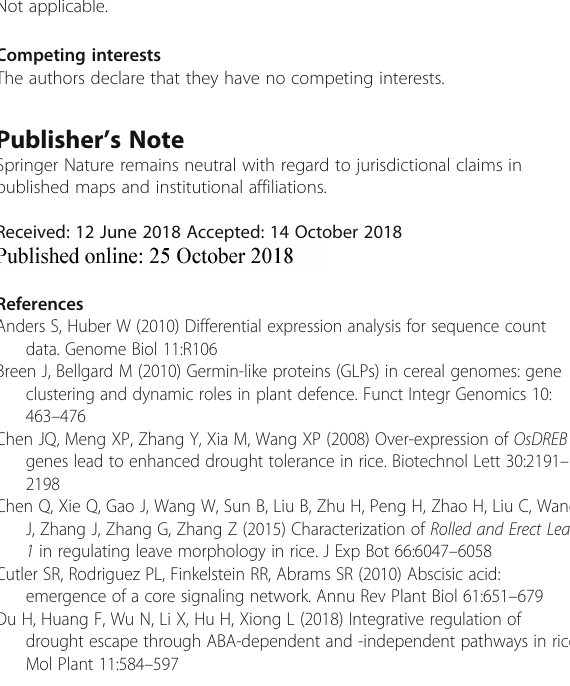
and its (Additional file 1: Table S12, Additional file 2: Table S1, Additional file 3: Figure S1, Additional file 4: Figure S2, Additional file 5: Table S2, Additional file 6: Figure S3, Additional file 7: Figure S4, Additional file 8: Table S3, Additional file 9: Table S4, Additional file 10: Table S5, Additional file 11: Table S6, Additional file 12: Table S7, Additional file 13: Table S8, Additional file 14: Table S9, Additional file 15: Figure S5, Additional file 16: Table S11, Additional file 17: Table S12, respectively). Authors ’ contributions QX and ZZ together designed the experiments. JL performed most of the experiments assisted by SG, BS, QL, XC, and HP. JL and SG performed the drought and ABA response. JL and QL analyzed the RNA-seq and iTRAQ datasets. JL, XC and HP conducted the plant growth in greenhouse and paddy field. JL and QX wrote the manuscript. All authors have discussed